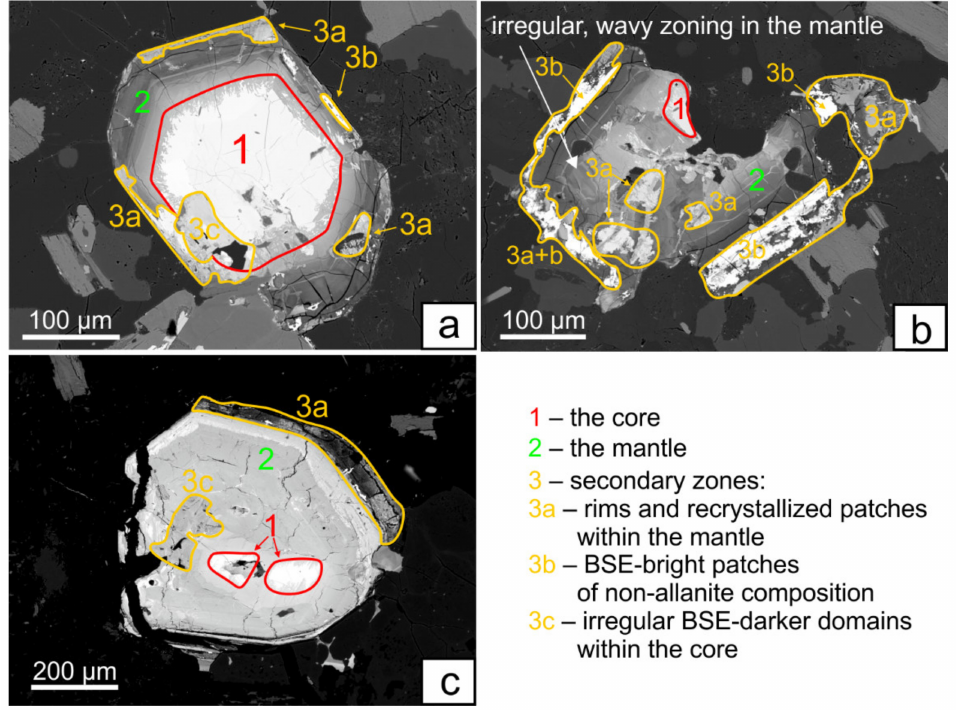
Figure 2. Selected allanite grains with marked textural zones 1 to 3; ( a ) GR-1, ( b ) GR-2, and ( c )